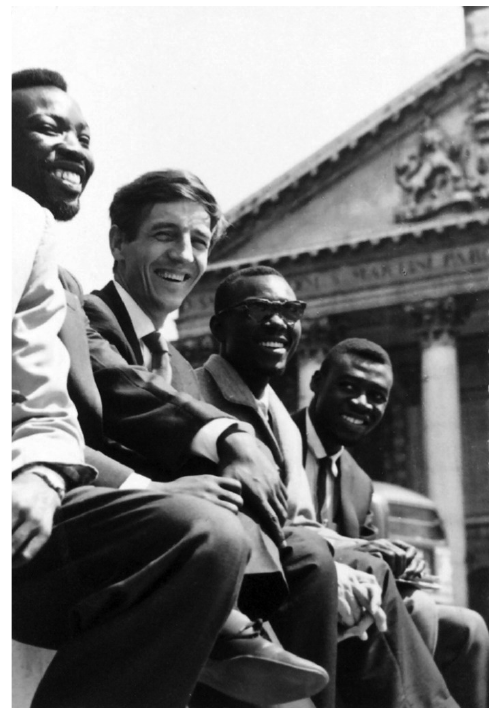
Figure 7. John Lloyd with KNUST students on a field trip to London sponsored by British Technical Aid, June 1964.